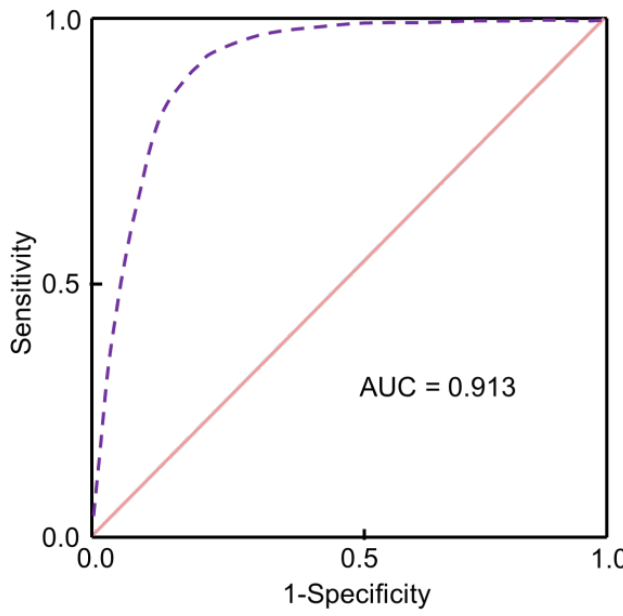
Figure 10. ROC curves obtained for the model accuracy evaluation.